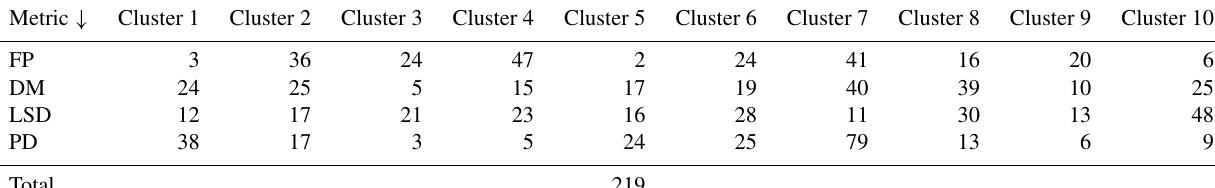
Figure 15. Region-wise graph properties: (a) fingerprints, (b) network portrait ensembles, and (c) heat trace vectors. Table 4. Summary of subgraphs within each cluster of Region 1 for k =